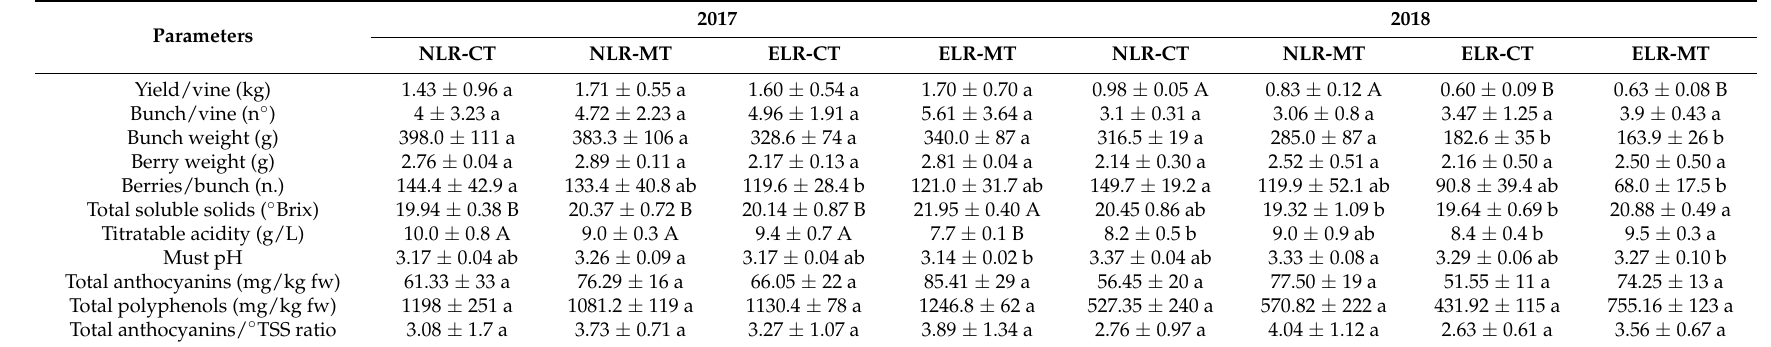
Table 3. Impact of early basal leaf removal and soil tillage on yield components and main berry quality attributes (NLR-CT = No Leaf Removal-Conventional Tillage; NLR-MT = No Leaf Removal-Minimum Tillage; ELR-CT = Early Leaf Removal-Conventional Tillage; ELR-MT = Early Leaf Removal-Minimum Tillage). Data are presented as means ± standard deviations. Means for each parameter indicated by different letters are significantly different ( p ≤ 0.05), based on Tukey’s HSD post hoc test within treatment and